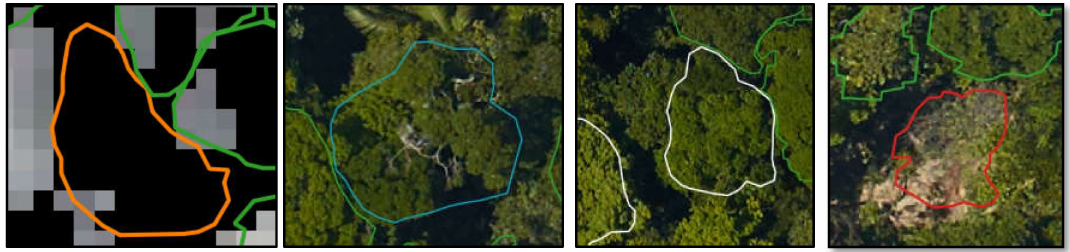
Figure A2. From left to right: low illumination ratio from hyperspectral images, wood contribution, lianas contribution and ground